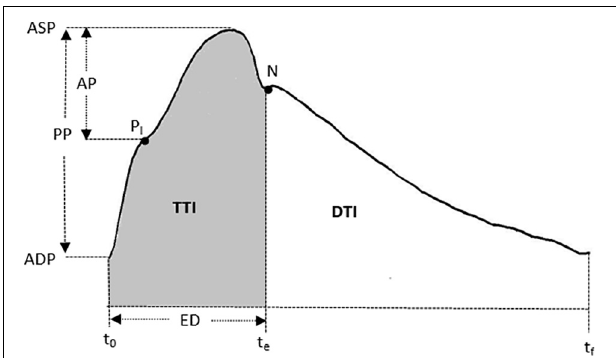
FIGURE 1 | A typical central (ascending aortic) pressure waveform. The AIx = AP/PP. AP, augmentation pressure; PP, pulse pressure; PI is the pressure of inflection point. ASP, aortic systolic pressure; ADP, aortic diastolic pressure; ED, ejection duration. t 0 is the time at the foot. t e is the notch of aortic pressure waveform. t f is the end time of an averaged waveform. N is the notch point. SEVR, DTI/TTI. DTI, diastolic time index; TTI, tension time